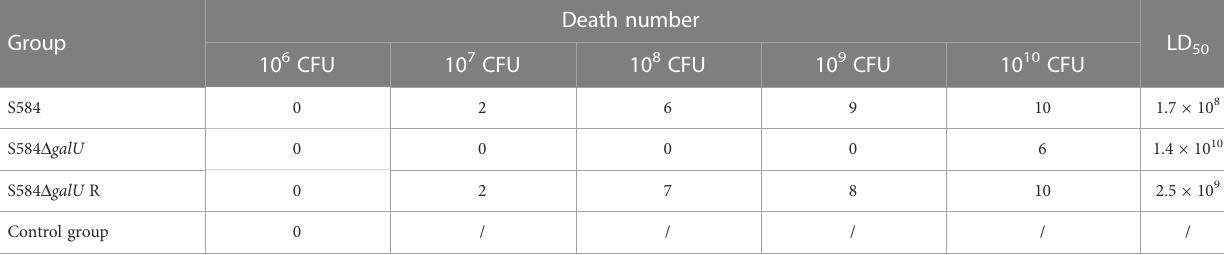
The / symbol indicates that this part of the test was not carried